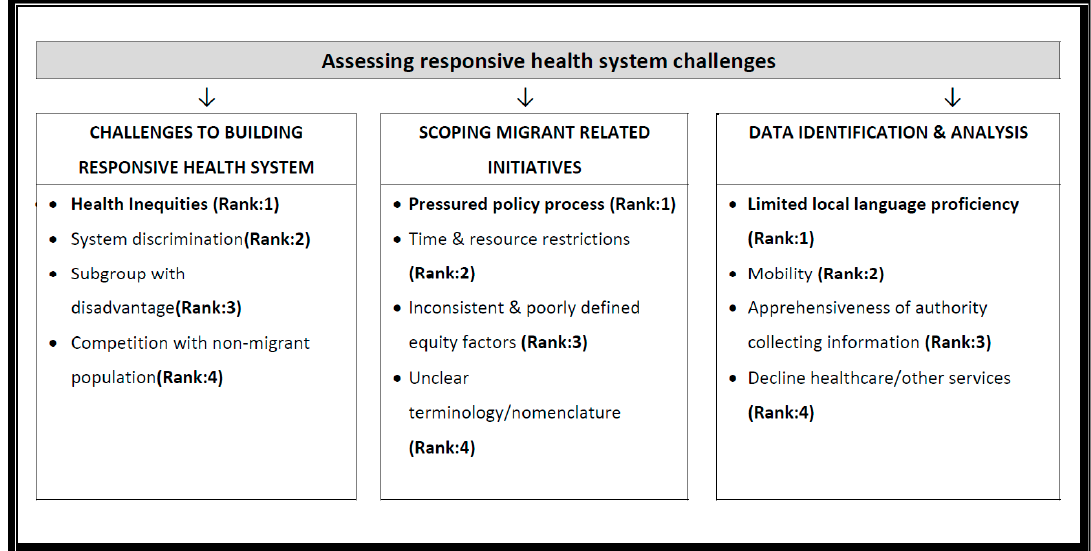
Figure 3. Priority ranked results on assessing responsive health system challenges.